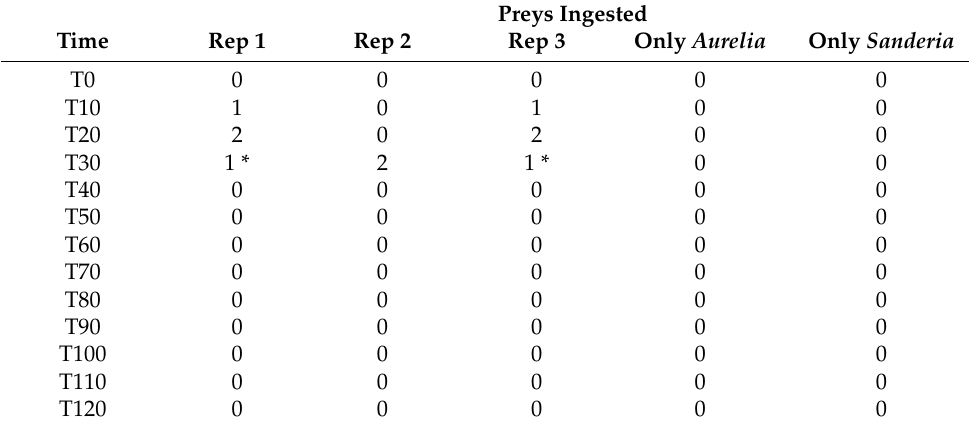
Table 4. Interaction between S. malayensis and A. solida ephyrae. T0–T120 (min). * Indicates predation without